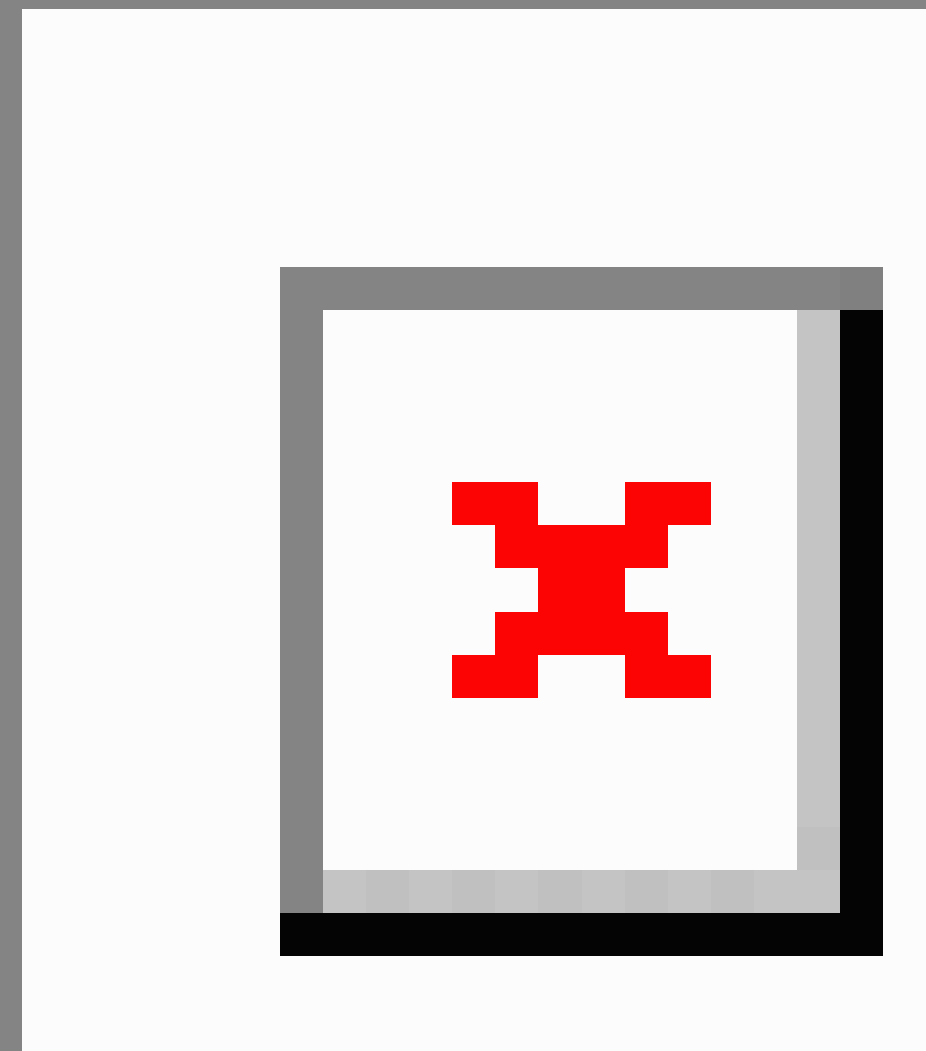
Figure 11. Community profile: Service